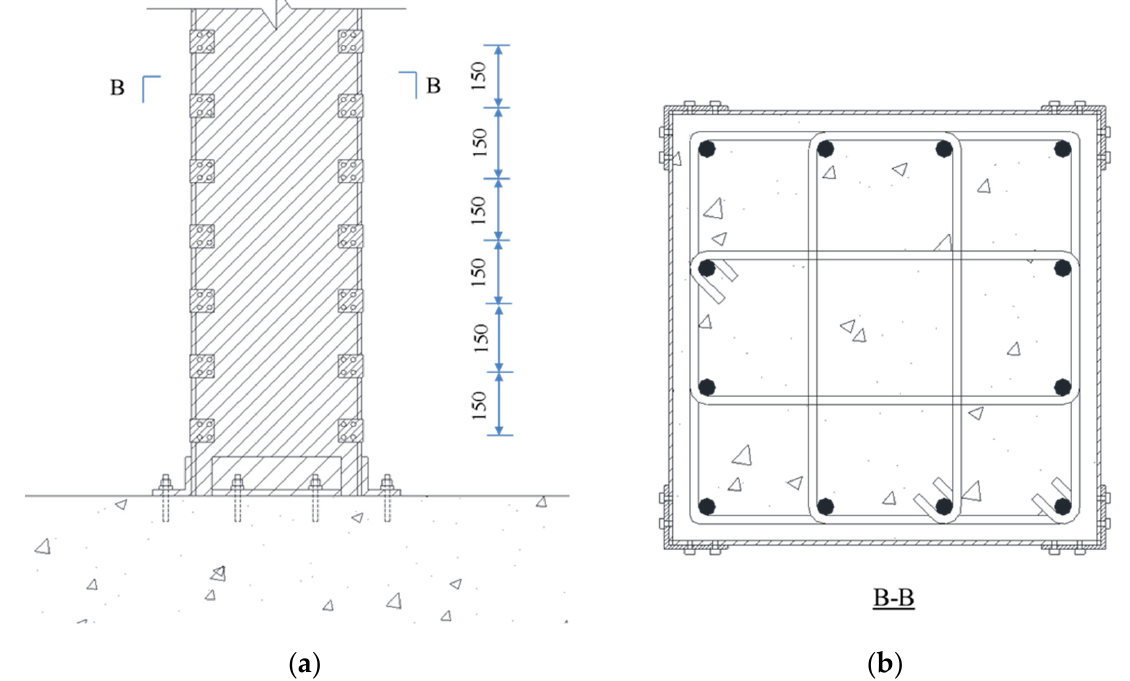
Figure 11. Strengthened RC column: ( a ) front view; ( b ) plane view.